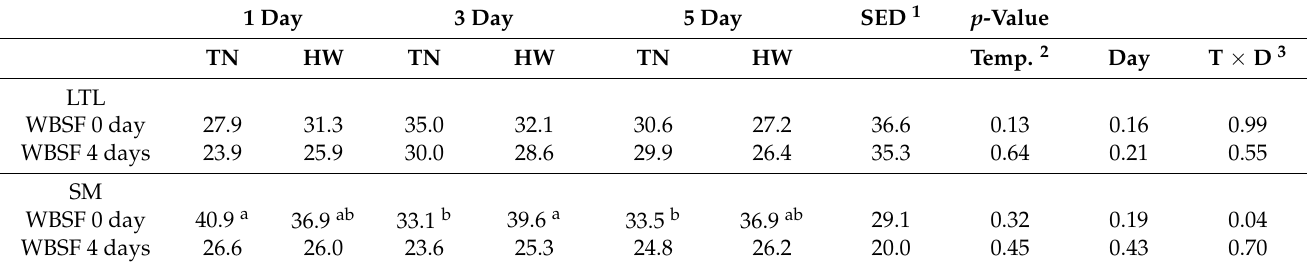
Table 2. The effect temperature (thermoneutral, TN vs. heatwaves, HW) and heat exposure duration (1 vs. 3 vs. 5 days) on Warner–Bratzler shear force (WBSF) of longissimus thoracis et lumborum (LTL) and semimembranosus (SM) muscles during 4 days’ overwrap retail display ( n = 12 per